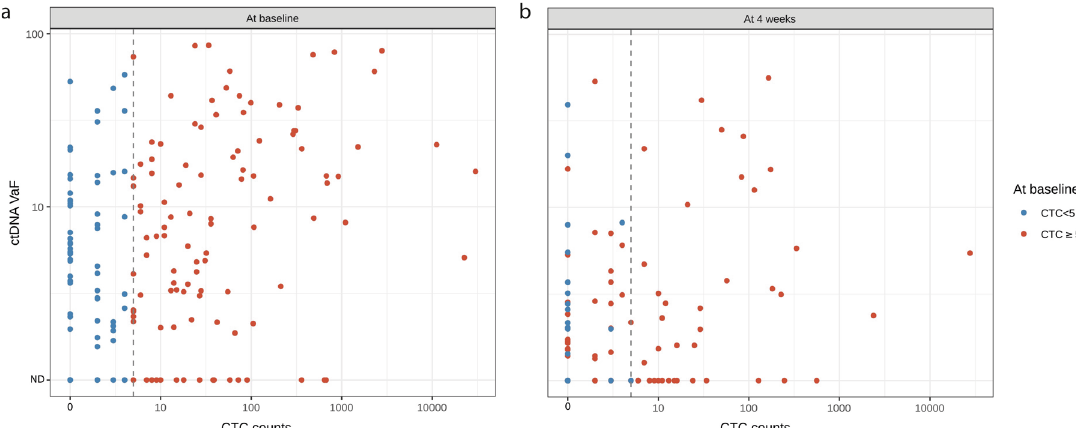
Fig. 2 Correlation between CTC counts and ctDNA levels (logarithmic scale). Each dot represents ctDNA variant allelic fractions (VAF) as a function of CTCs counts ( a at baseline, b at four weeks). ND ctDNA not detected. Dashed line highlights the 5 CTC